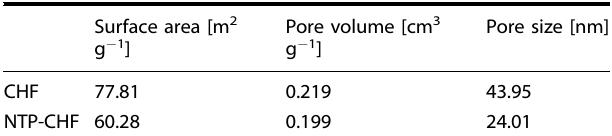
Table 1. Physical properties of CHF and